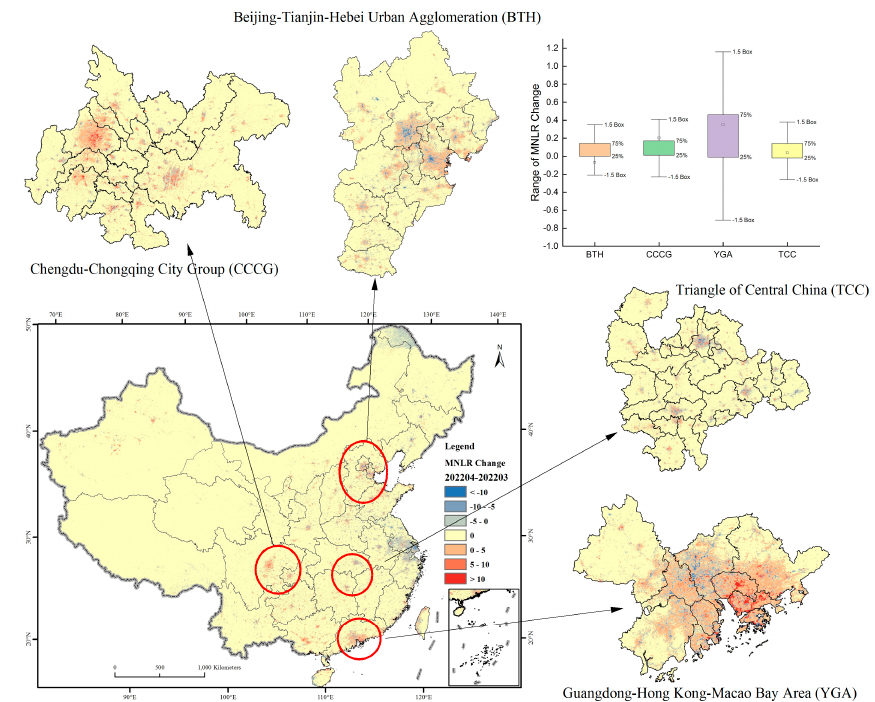
Figure 6. Spatio-temporal variation of MNLR of major agglomerations from March to April 2022. The urban agglomeration name abbreviations are: Yang tz e River Delta Urban Agglomeration (YRD), Beijing–Tianjin–Hebei Urban Agglomeration (BTH), Guangdong–Hong Kong–Macao Bay Area (YGA), Triangle of Central China (TCC) and Chengdu–Chongqing City Group (CCCG).